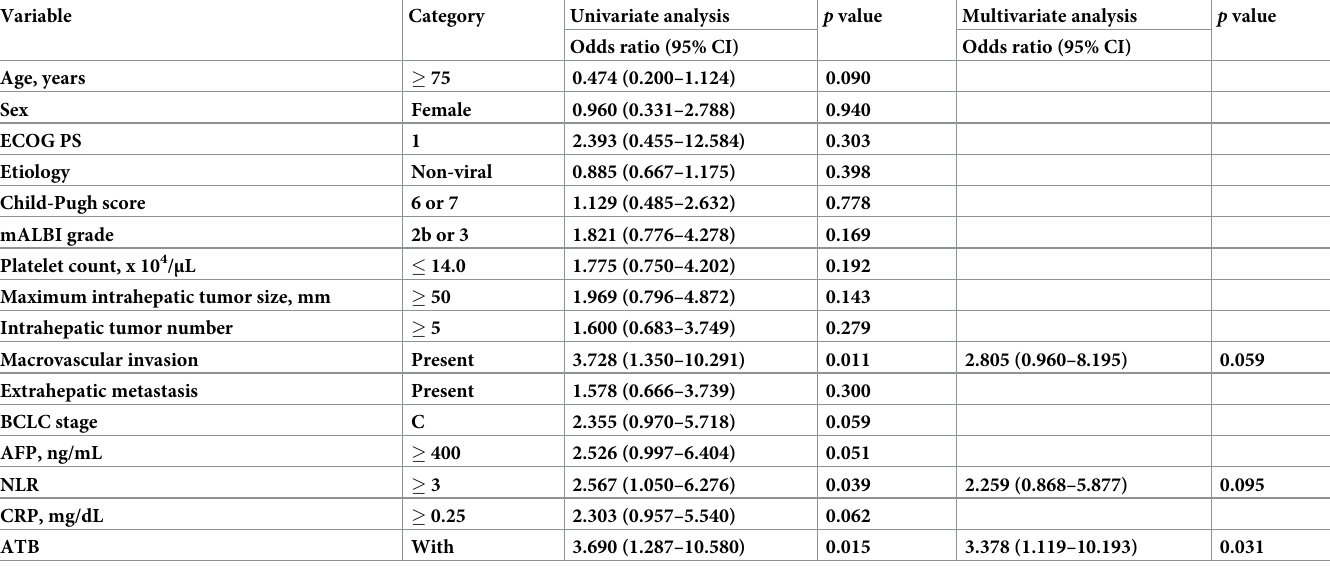
Table 4. Univariate and multivariate analyses of factors associated with progressive disease according to RECIST v1.1.